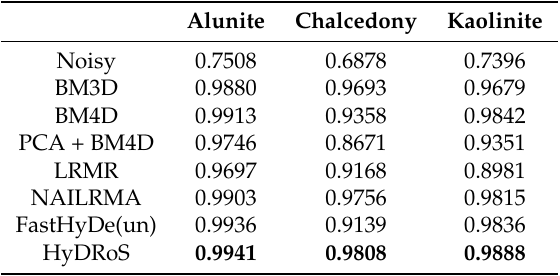
Figure 9. ROC curves for the three minerals obtained by SFF: ( a ) Alunite; ( b ) Chalcedony; ( c ) Kaolinite. Table 2. AUC obtained by SAM for AVIRIS noise-reduced HSI data at Cuprite Mining District.